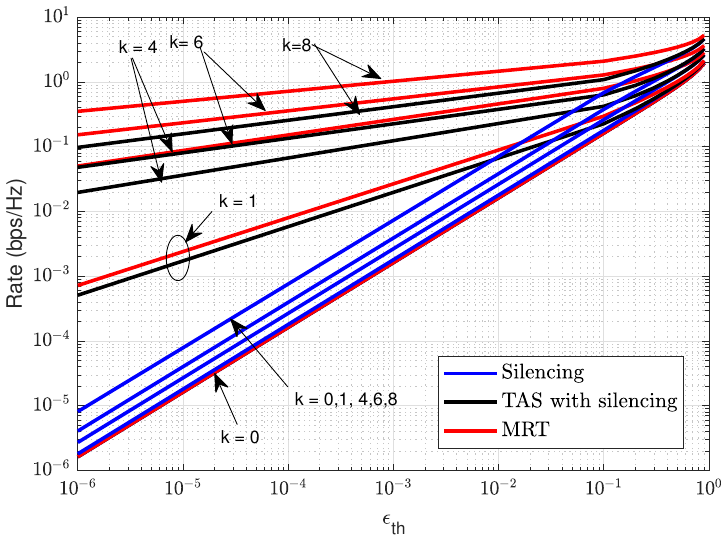
Figure 7. Illustration of rate control analysis with reliability constraint ( (cid:101) th ) for silencing, TAS with silencing and MRT schemes with N = 10 and different number of cooperating RRHs k